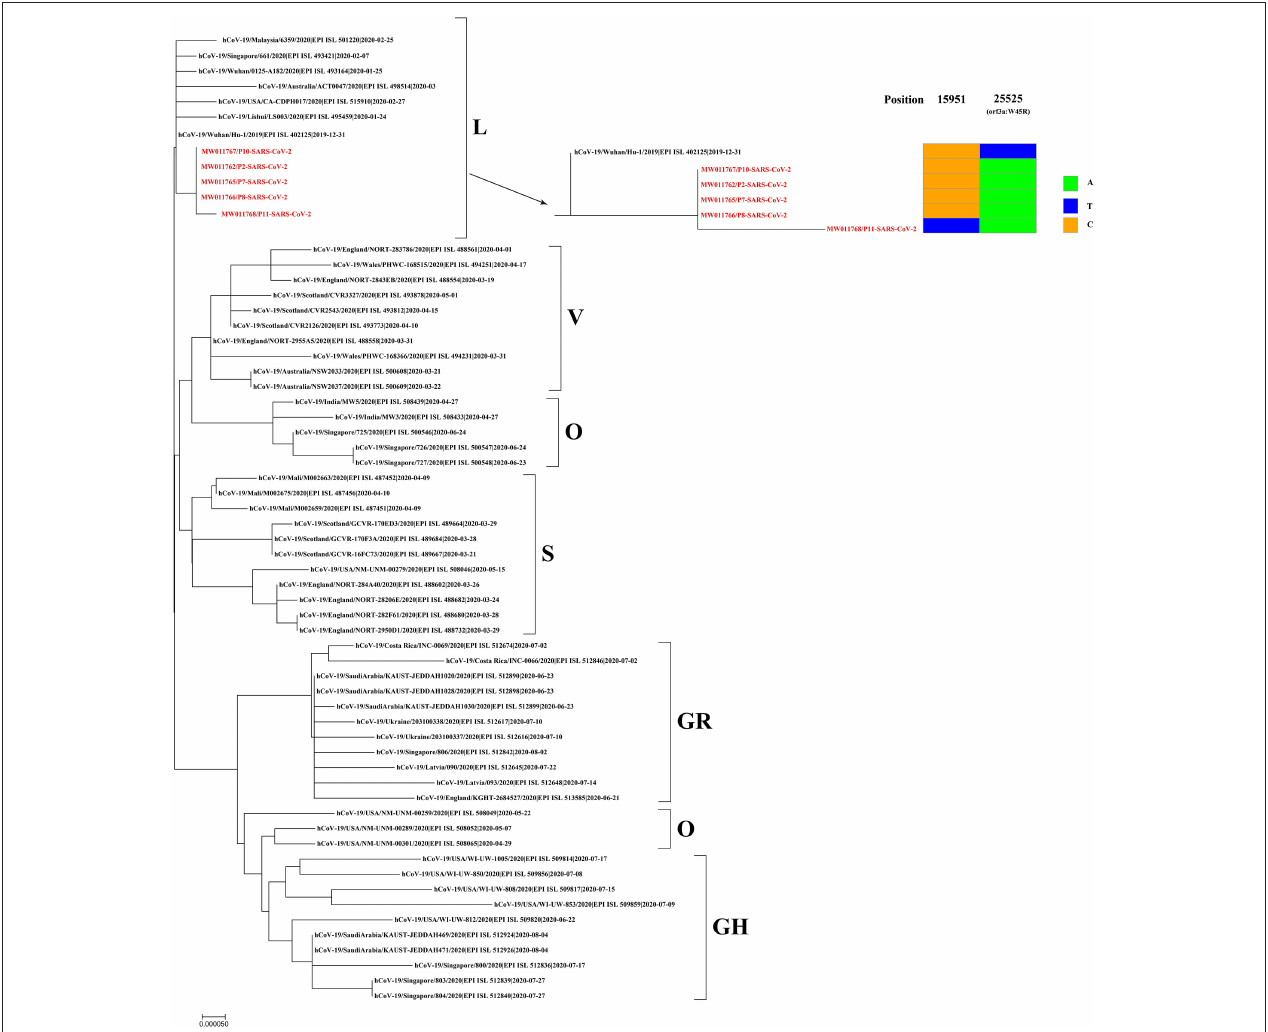
FIGURE 3 | Phylogenetic analysis and sequence comparison of the SARS-CoV-2 genomes sequenced in this study. Phylogenetic analysis was performed based on five complete SARS-CoV-2 genomes sequenced in this study (marked in red) and 57 representative genomes from different SARS-CoV-2 clades. Single nucleotide polymorphisms (SNPs) from the SARS-CoV-2 genomes sequenced in this study are presented in comparison to the first published genome, Wuhan-Hu-1 (GenBank no. NC_045512). New SARS-CoV-2 genomes have been deposited in GenBank, and the accession numbers are given in